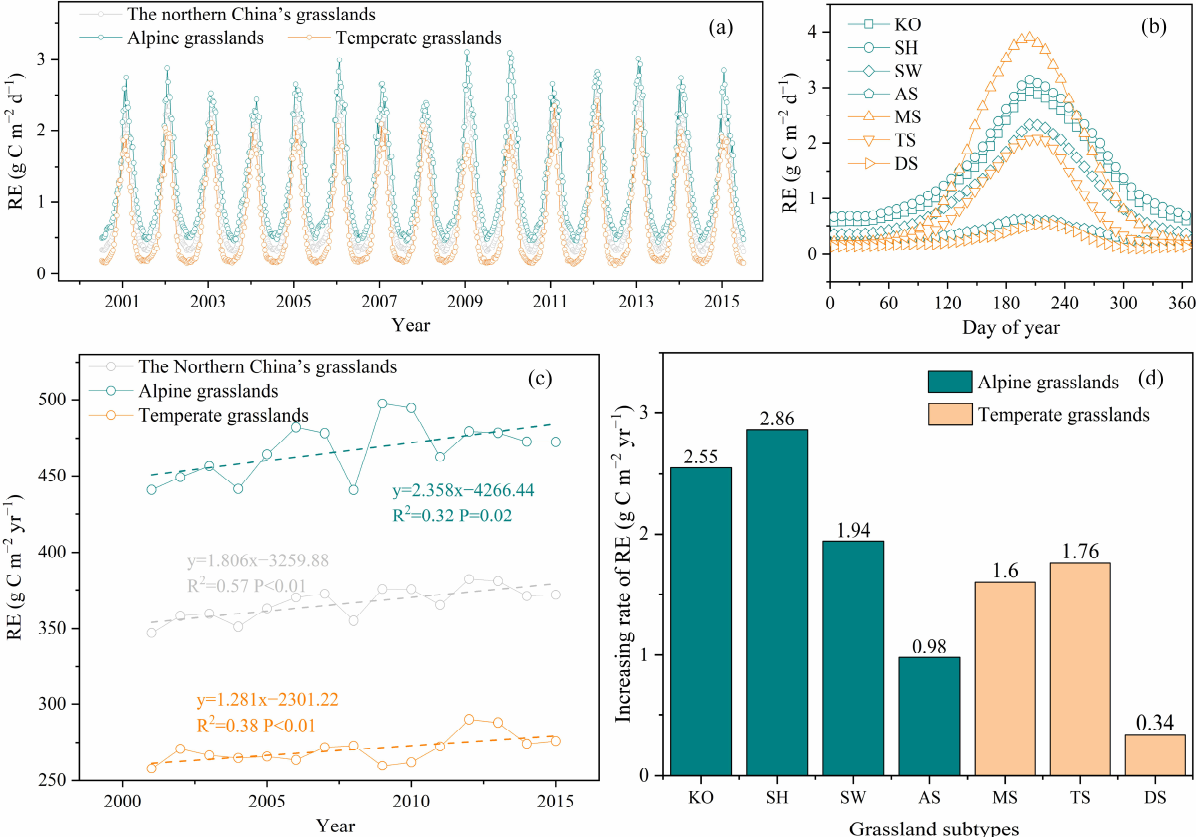
Figure 6. ( a ) Seasonal dynamics of RE at the regional scale from 2001–2015; ( b ) seasonal dynamics of mean 15-year seasonal RE in the seven grassland subtypes; ( c ) interannual dynamics of RE at the regional scale from 2001–2015; ( d ) the increasing rate of RE of the seven grassland subtypes.